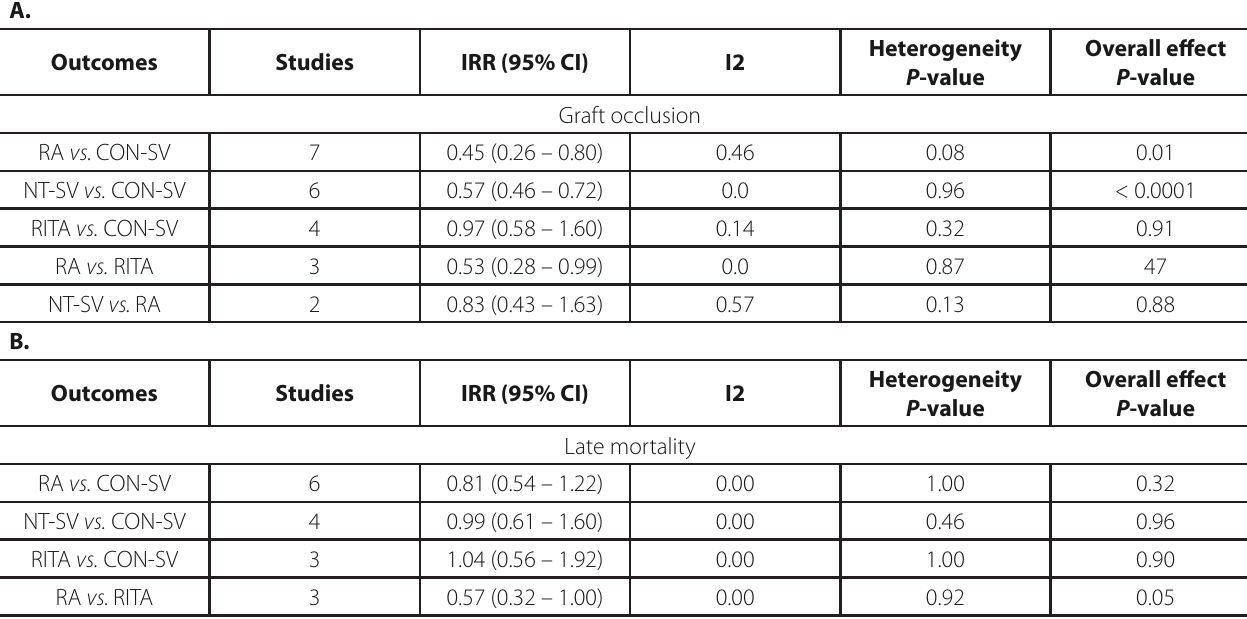
Table S6. Summary of different pairwise comparisons using random effects modeling for A) graft occlusion and B) late mortality. For each pairwise comparison, the second group is the reference